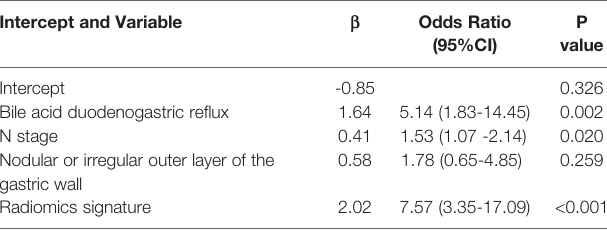
TABLE 4 | Multivariate analysis of risk factors for the radiomics nomogram.